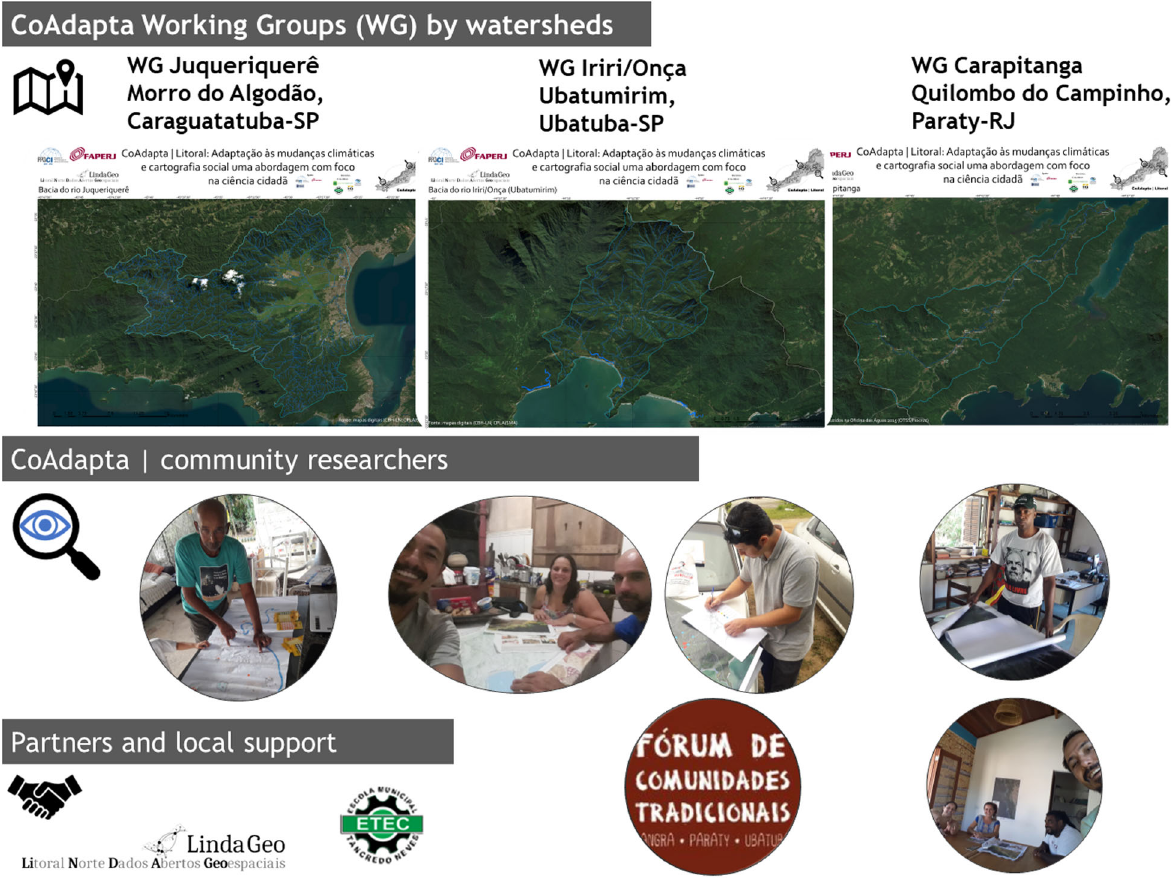
Fig. 3 CoAdapta working groups (WG): WG Juqueriquerê (Caraguatatuba-SP), WG Iriri/Onça (Ubatuba-SP) and WG Carapitanga (Paraty-RJ).